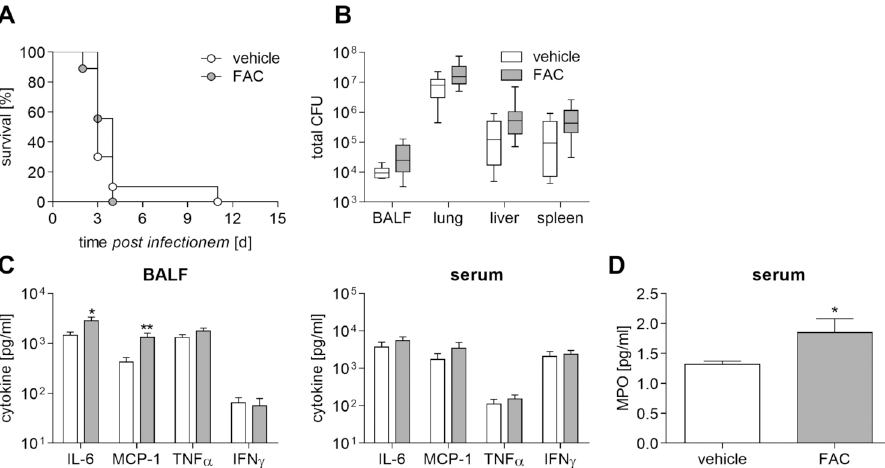
Fig 7. Iron availability promotes bacterial growth at the primary site of infection and increases the inflammatory response. FAC (5 mg/kg) or vehicle (D-PBS)-treated C57BL/6 mice were intranasally inoculated with B . pseudomallei at 500 CFU. (A) Cumulative survival rate between groups was compared using Log-rank Kaplan-Meier test (2 independent experiments, n = 10). (B) 48 hours after infection, the bacterial load (CFU) in BALF (n = 8) and organs (n = 10) was determined. Data from two experiments are expressed as box and whisker plots indicating minimum, maximum, quartiles and median. (C) Cytokine production (IL-6, MCP-1, TNF α , IFN γ ) in BALF (n = 8) and serum (n = 10), and (D) myeloperoxidase (MPO) levels in serum (n = 5) were measured 48 hours after infection. (C, D) Data from two experiments are presented as mean with SEM. (B-D) Statistical analyses were done using a Student’s t- test ( (cid:3) p < 0.05, (cid:3)(cid:3) p <